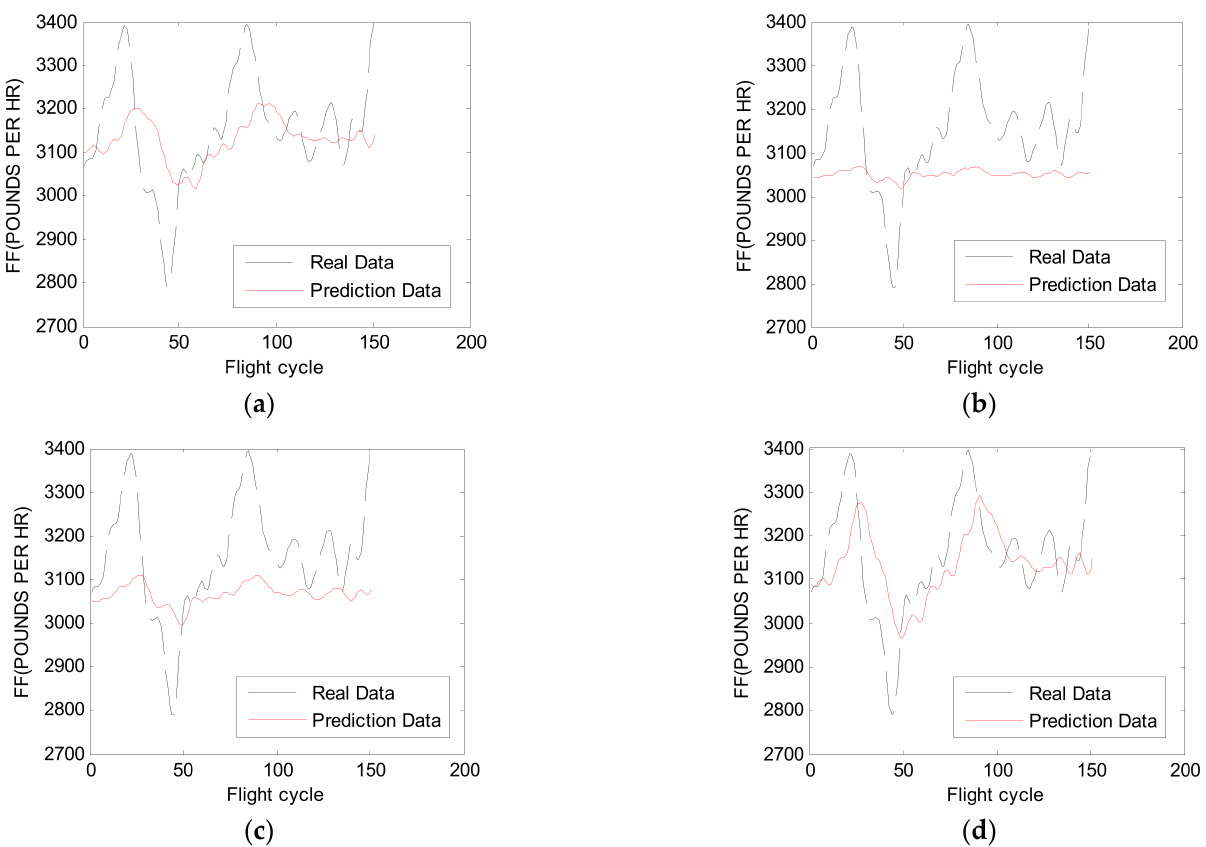
Figure 9. The prediction effect of each algorithm: ( a ) LM; ( b ) HLM; ( c ) TSLM; ( d ) AdaLM.